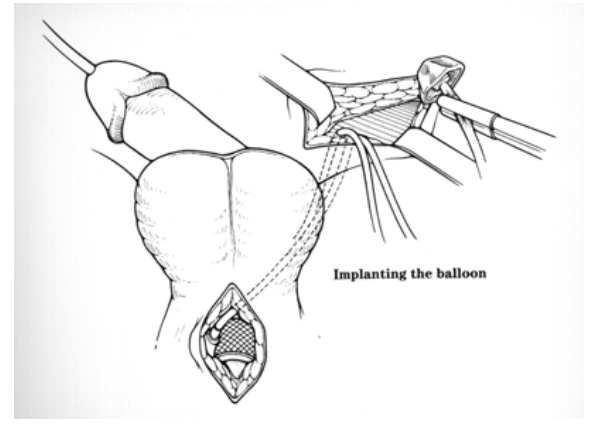
FIGURE 6. Placement of balloon reservoir deep to the rectus